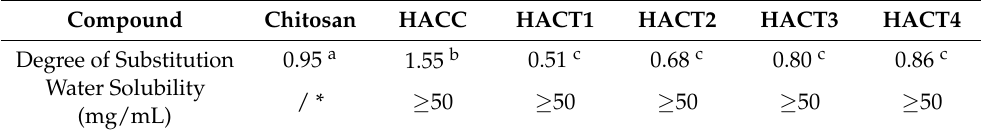
Figure 2. 1 H NMR spectra of chitosan and chitosan derivatives. Table 1. The degrees of substitution and water solubility of chitosan derivatives.